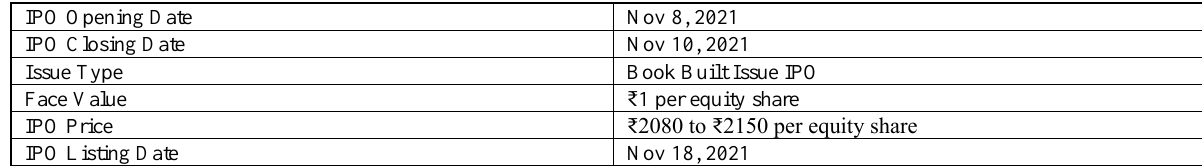
Table 2. Paytm IPO Details